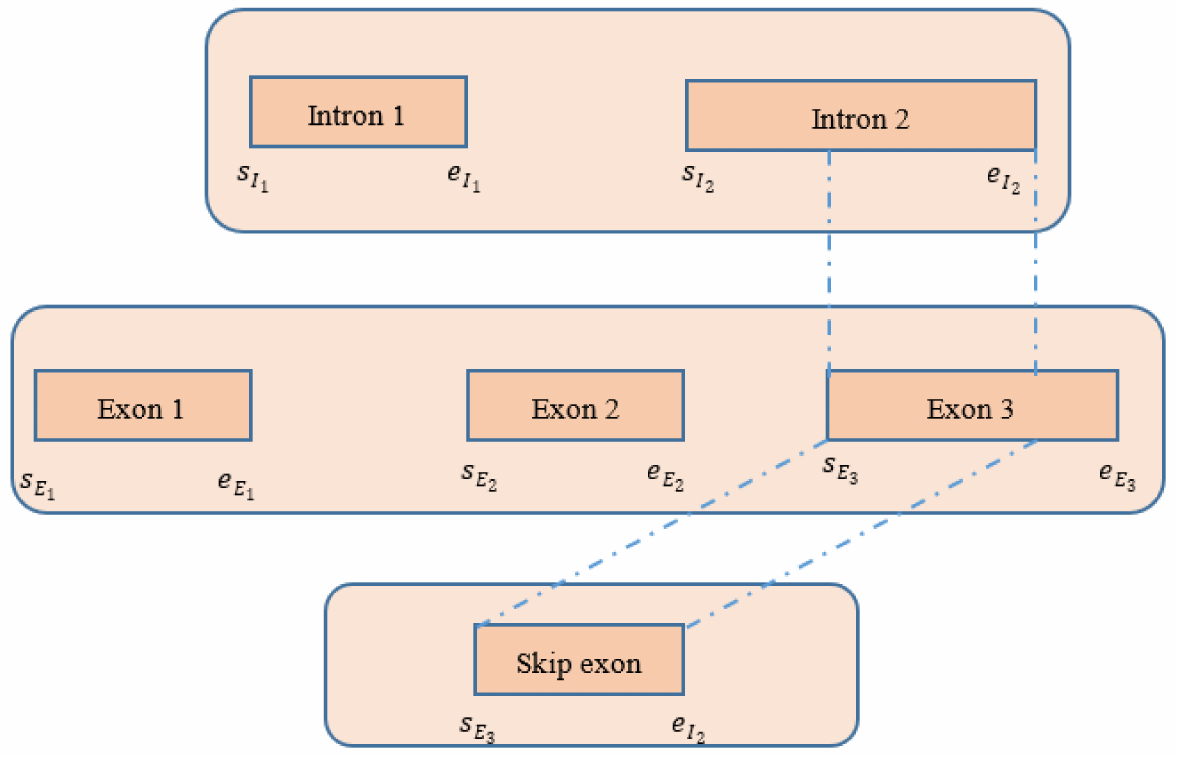
Figure 7. Procedure of detecting skip exon after extracting exons and introns from the CIGAR string of the spanning chimeric